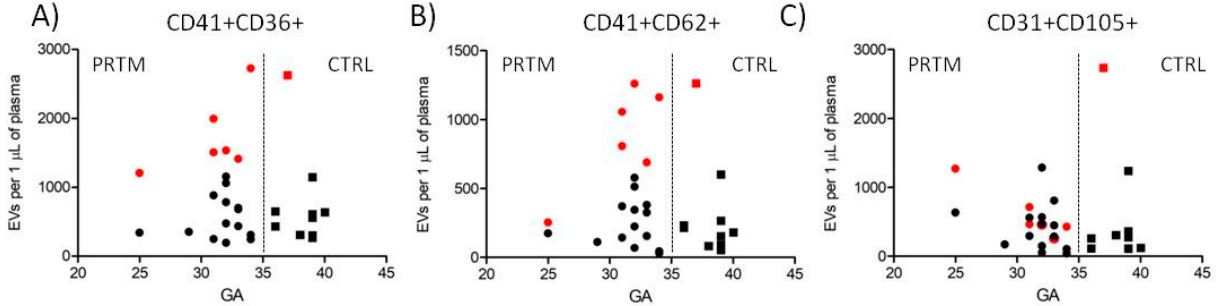
Figure 3. Counts of cord blood plasma large EVs plotted against newborn gestational age. ( A ) Platelet (CD41+CD36+), ( B ) activated platelet (CD41+CD62+), and ( C ) endothelial (CD31+CD105+) EVs in preterm newborns (PRTM; circles, n = 20) and control newborns (CTRL; squares, n = 10). Gestational age (GA) is in weeks. Red symbols represent hemolytic samples (Hb > 0.1 mg/mL). Table 2. EV counts in PRTM and CTRL presented as a mean ± SD. Differences between PRTM and CTRL groups were not significant.